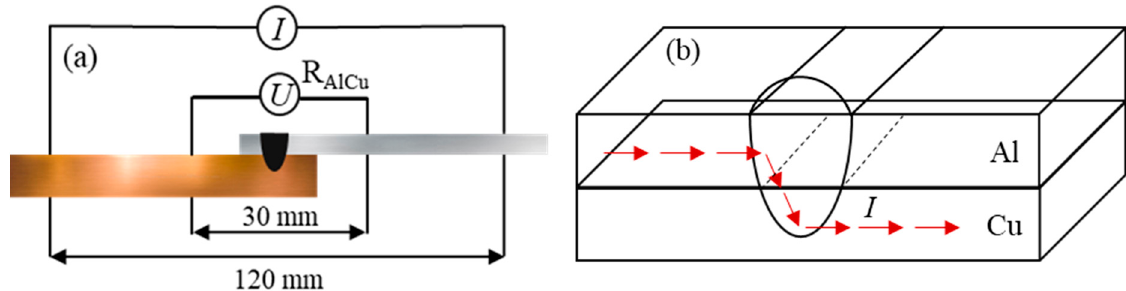
Figure 4. Electrical contact resistance measurement: ( a ) schematic; ( b ) current flow direction. Microhardness was measured using a Vickers microhardness tester (Mitutoyo HM-100 series) to investigate the mechanical properties of the weld. Measurements were performed at a 50-gf load and 10 s dwell time. Indentations were carried out horizontally along the weld cross-section at three different positions, as shown in Figure 5.